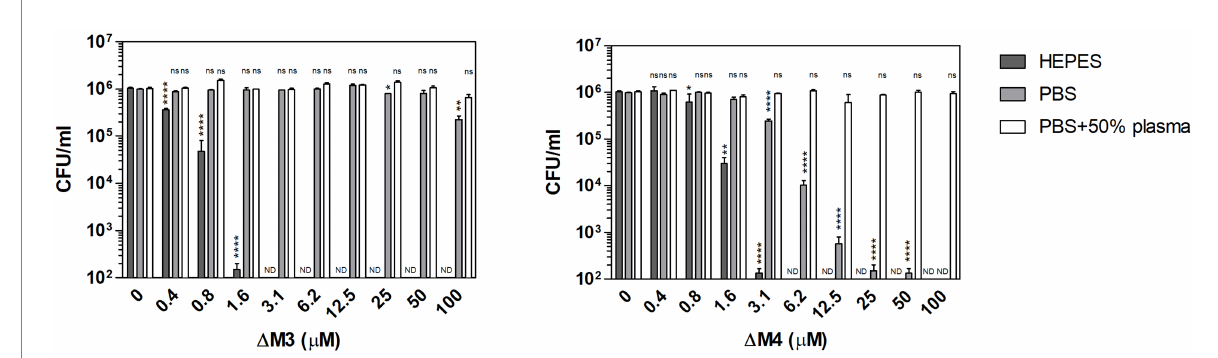
FIGURE 2 Fungicidal activity of Δ M3 and Δ M4 against C. albicans under various conditions. C. albicans yeast cells (10 5 /100 μ l) were incubated with Δ M3 and Δ M4 at concentrations in a range of 0.4–100 μ M for 2 h in 10 mM HEPES, PBS, or PBS with 50% human plasma. The cell suspensions were plated on solid YPD medium. After 24 h of cultivation at 30 ° C, the number of CFUs was determined. The experiment was performed in triplicate. Graphs present mean values ± SD from representative results ( n = 4). For statistical analysis one-way ANOVA with Dunnett’s multiple comparisons post hoc test was used (* p < 0.05, ** p < 0.005, **** p < 0.0001, ns > 0.05 vs. untreated cells). A value of 10 2 CFU/ml on the y-axis was the limit of quantification. Values that were below this limit were marked